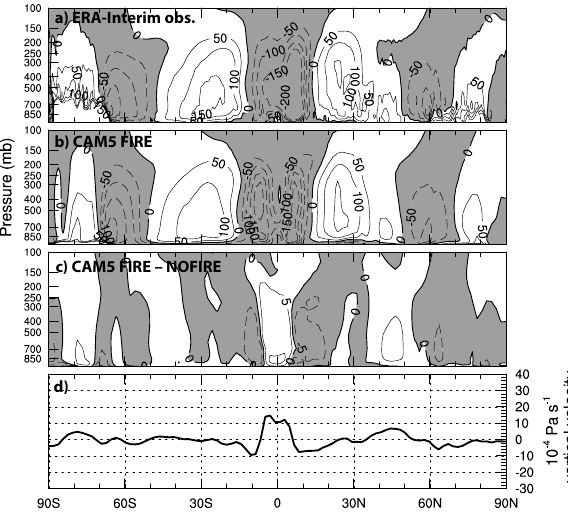
Fig. 8. Zonal-mean (annual) vertical velocities ( ω ) derived from (a) ECMWF ERA-interim observations, (b) CAM5 simulations in- cluding fire aerosols, and (c) the difference between the FIRE and NOFIRE simulations. Units are in 10 − 4 Pa s − 1 for all plots. Con- tour intervals vary. Negative values (shaded regions) indicate up- ward velocities, positive values (un-shaded regions) are downward velocities. (d) is the 500mb vertical velocity anomalies (as in c